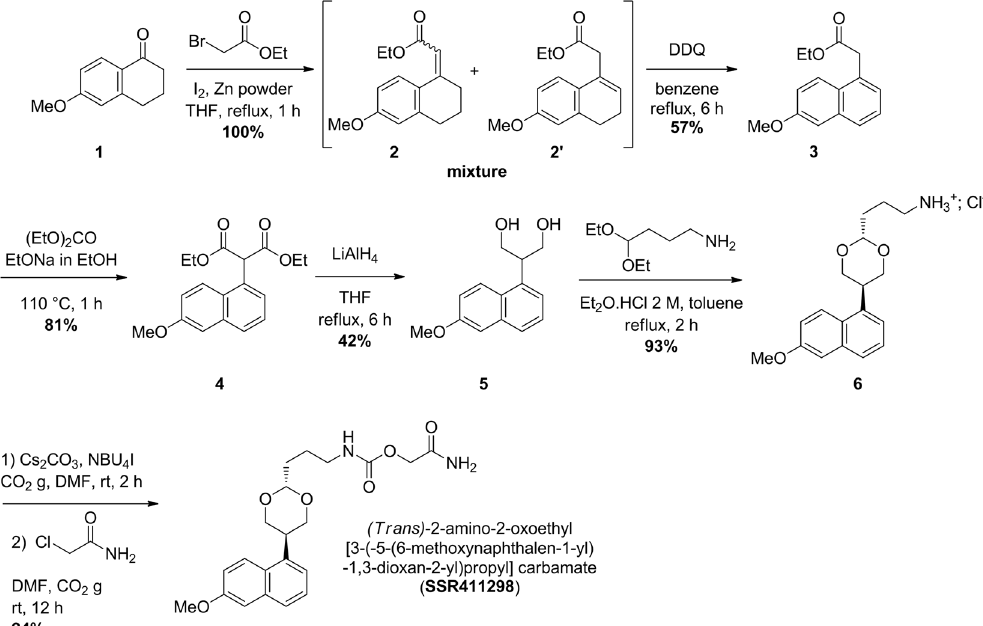
Figure 1. Synthesis of SSR411298. The compound was prepared in 24% yield by carbamation of ( trans )- 3-[-5-(6-methoxynaphtalen-1-yl)-1,3-dioxan-2-yl]propanamine ( 6 ) with chloroacetamide. Compound ( 6 ) was obtained via the dioxane formation of 2-(6-methoxynaphtalen-1-yl)propan-1,3-diol ( 5 ) with 4,4-diethoxybutanamine, in 93% yield. Compound ( 5 ) was isolated in 42% yield from the reduction of diethyl-2-(6-methoxynaphtalen-1-yl)propanedioate ( 4 ). Compound ( 4 ) was synthesized by alkylation of ethyl-(6-methoxynaphtalen-1-yl)-acetate ( 3 ) with ethylcarbonate in 81% yield. Compound ( 3 ) was prepared in two steps, in 57% overall yield, consisting in a substitution-deshydratation sequence of 6-methoxy-1,2,3,4- tetrahydronaphtalen-1-one ( 1 ) with ethyl bromoacetate, followed by an oxydation of the naphtalene ring by